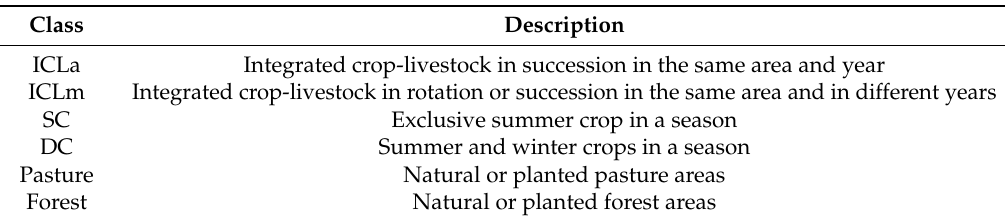
Table 2. Description of land cover classes.